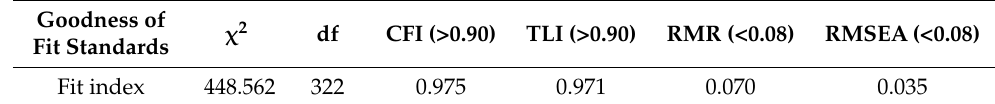
Table 4. Goodness of fit of research model.